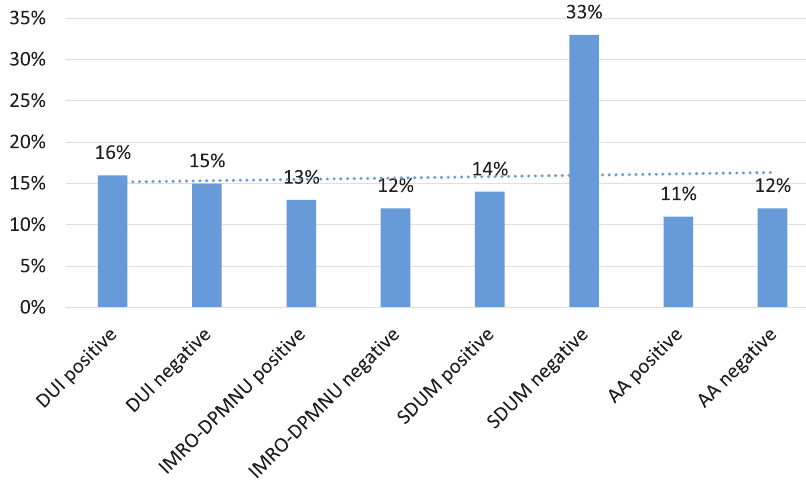
Figure 5. The perception of false information from politically not affiliated respondents.